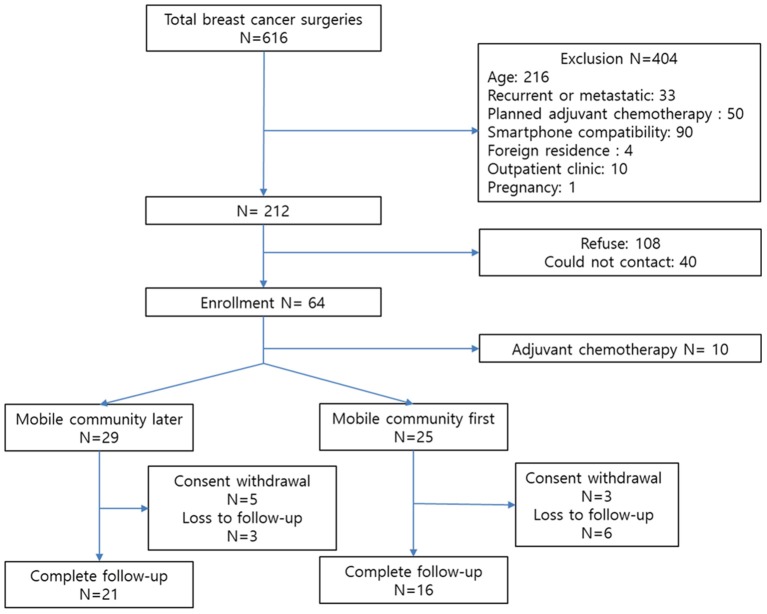
Study enrollment.